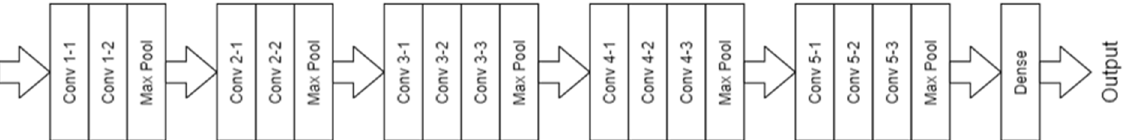
Figure 4 . The architecture of VGG16.